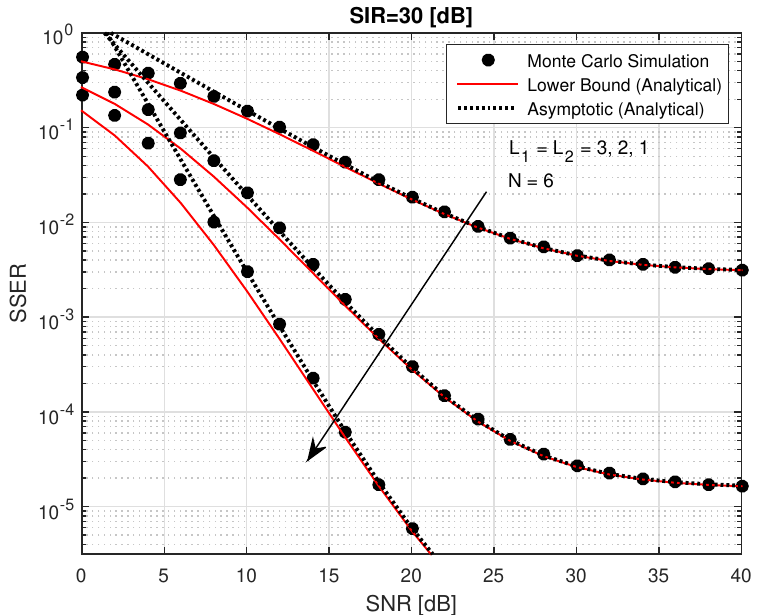
Figure 6. Sum SER performance of AF-TWRN with CCI for different number of antennas.